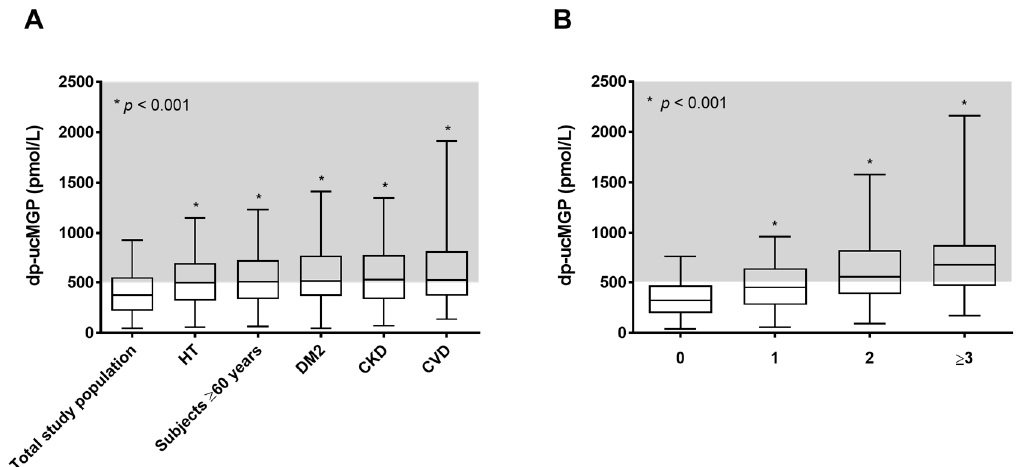
Figure 1. Dp-ucMGP levels in the total study population and for subjects with hypertension (HT), ≥ 60 years of age, type 2 diabetes (DM2), chronic kidney disease (CKD) and history of cardiovascular disease (CVD) ( A ); and dp-ucMGP levels according to the number of comorbidities (i.e., HT, DM2, CKD, and/or CVD) ( B ).